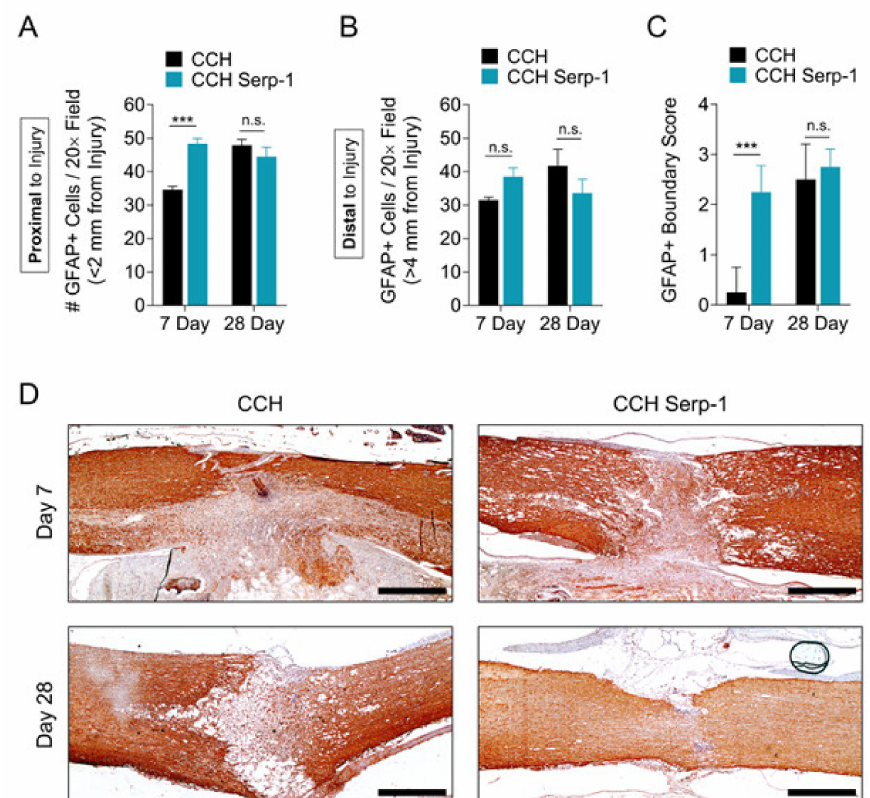
Figure 5. Serp-1 delivered by chitosan-collagen hydrogel stimulates protective astrogliosis in rat SCI. ( A, B ) GFAP + cell counts in fields (A) proximal ( < 2 mm) or (B) distal to the site of injury ( > 4 mm) in spinal cords of rats treated with 50 µ L chitosan-collagen hydrogel alone or 50 µ L chitosan-collagen hydrogel with 100 µ g Serp-1 at days 7 and 28 after injury. ( C ) Scoring of GFAP + boundaries around the area of injury in spinal cords of rats post-SCI treated as in panels A and B. Mean and standard error are presented. Statistics performed by Two-Way ANOVA with Fisher’s LSD post-hoc where *** p < 0.001 and n.s. is not significant. ( D ) Representative immunohistochemical staining (brown) of GFAP + cells of the same conditions quantified in panel A. Scale bars are 500 µ